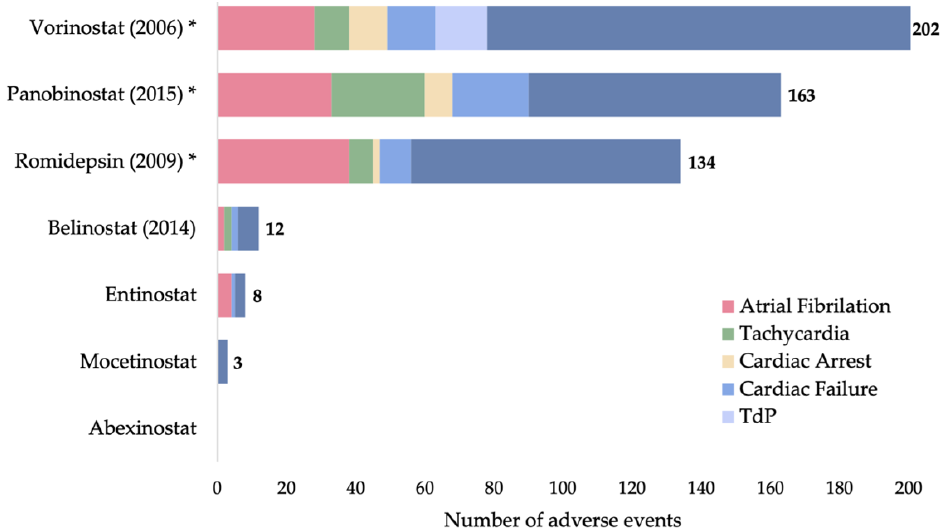
Figure 4. Adverse cardiac cases observed in patients being treated with HDACi (total number of adverse cases reported adjacent to each bar), retrieved from the FDA Adverse Event Reporting System (FAERS) Public Dashboard (fda.gov) on 22 November 2021. FDA approval year, when applicable, is listed in parentheses. * indicates possible TdP risk according to crediblemeds.org [144], accessed on 03 January 2022.